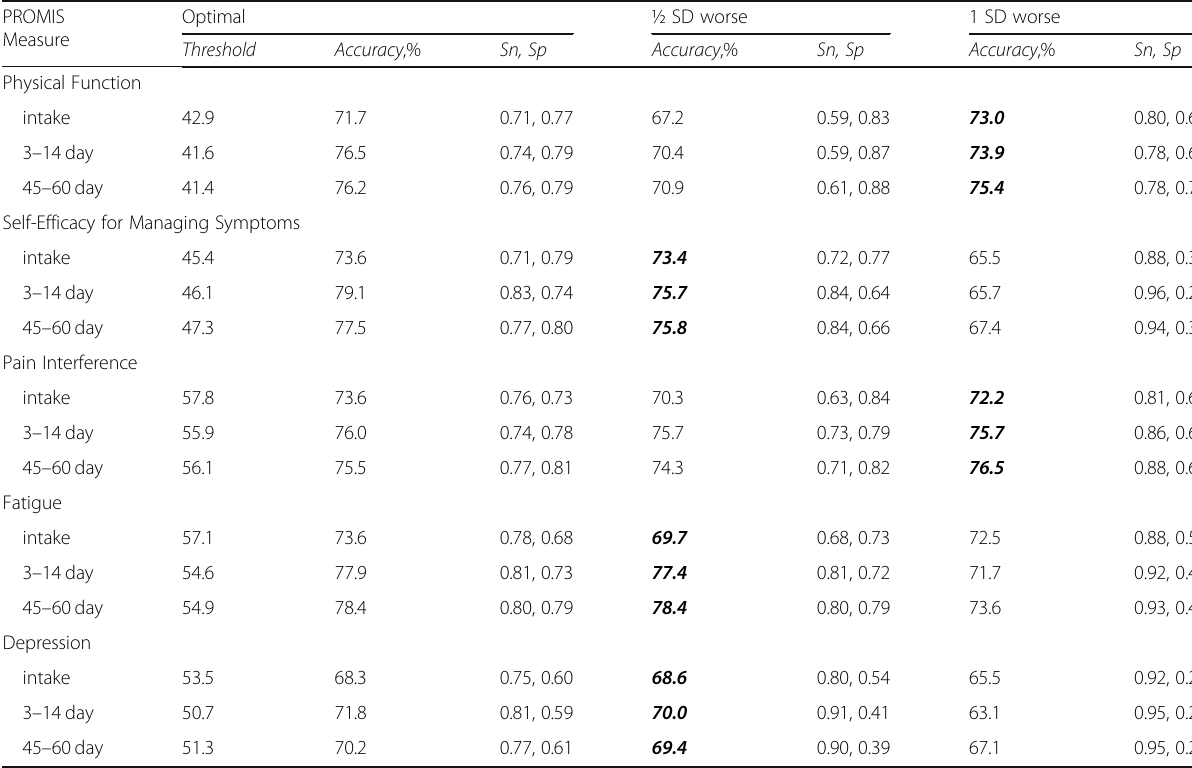
Table 3 T-score thresholds a accuracy at intake ( n = 360), 3 – 14 day follow-up ( n = 230), and 45 – 60 day follow-up ( n = 227) PROMIS Measure